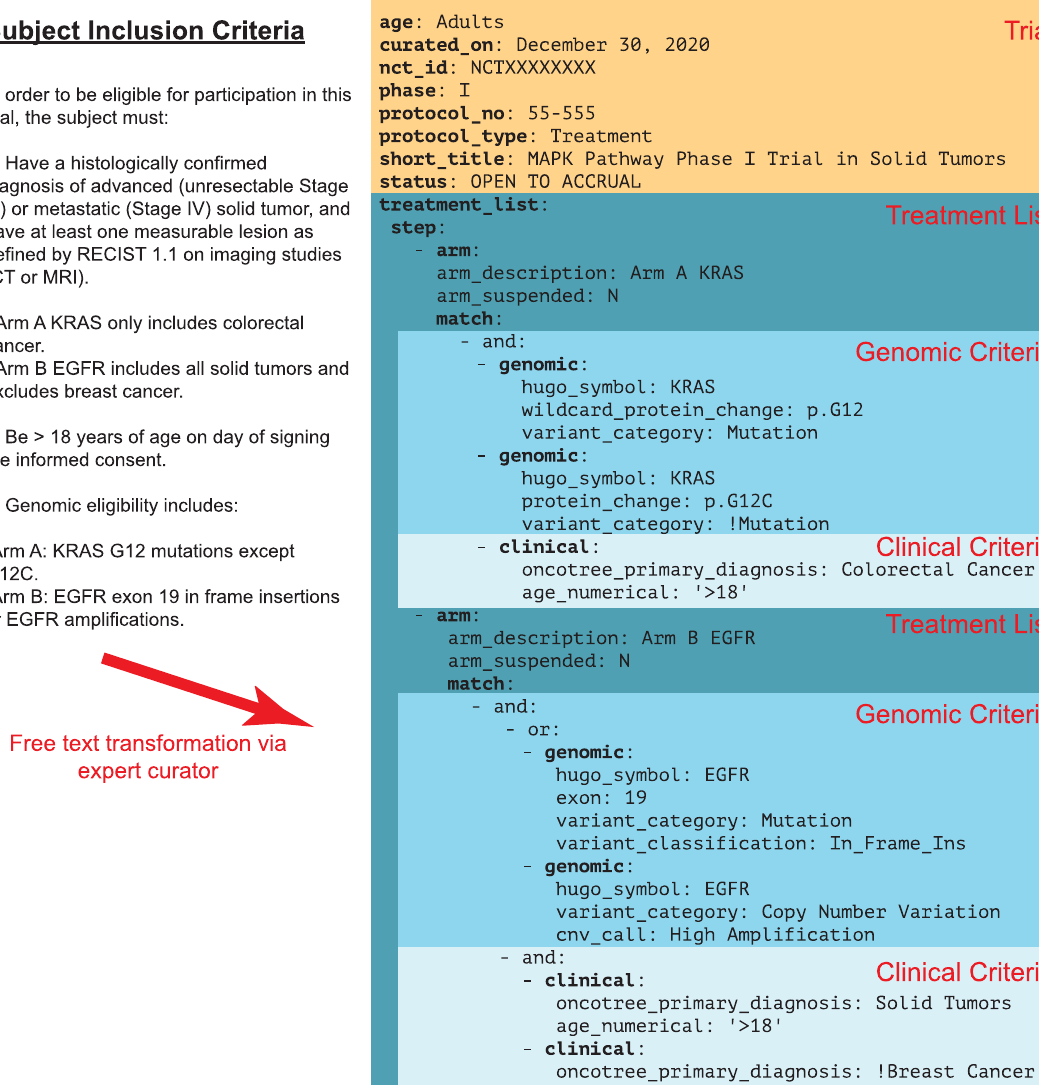
Fig. 2 Clinical trial markup language (CTML) provides a structured data format for PM trial eligibility criteria. a Free text subject eligibility criteria from an example PM trial protocol. Arm A is enrolling patients with colorectal cancer and any KRAS G12 mutation except G12C. Arm B is enrolling patients with EGFR altered (speci fi cally EGFR exon 19 insertions or EGFR ampli fi cations) solid tumors except breast cancer. b Trial details transformed into CTML, with curated information related to basic trial metadata (orange) and the treatment arms (dark blue) containing speci fi c genomic (turquoise) and clinical (light blue) match criteria. Arm A and B exclusions are annotated using exclamation